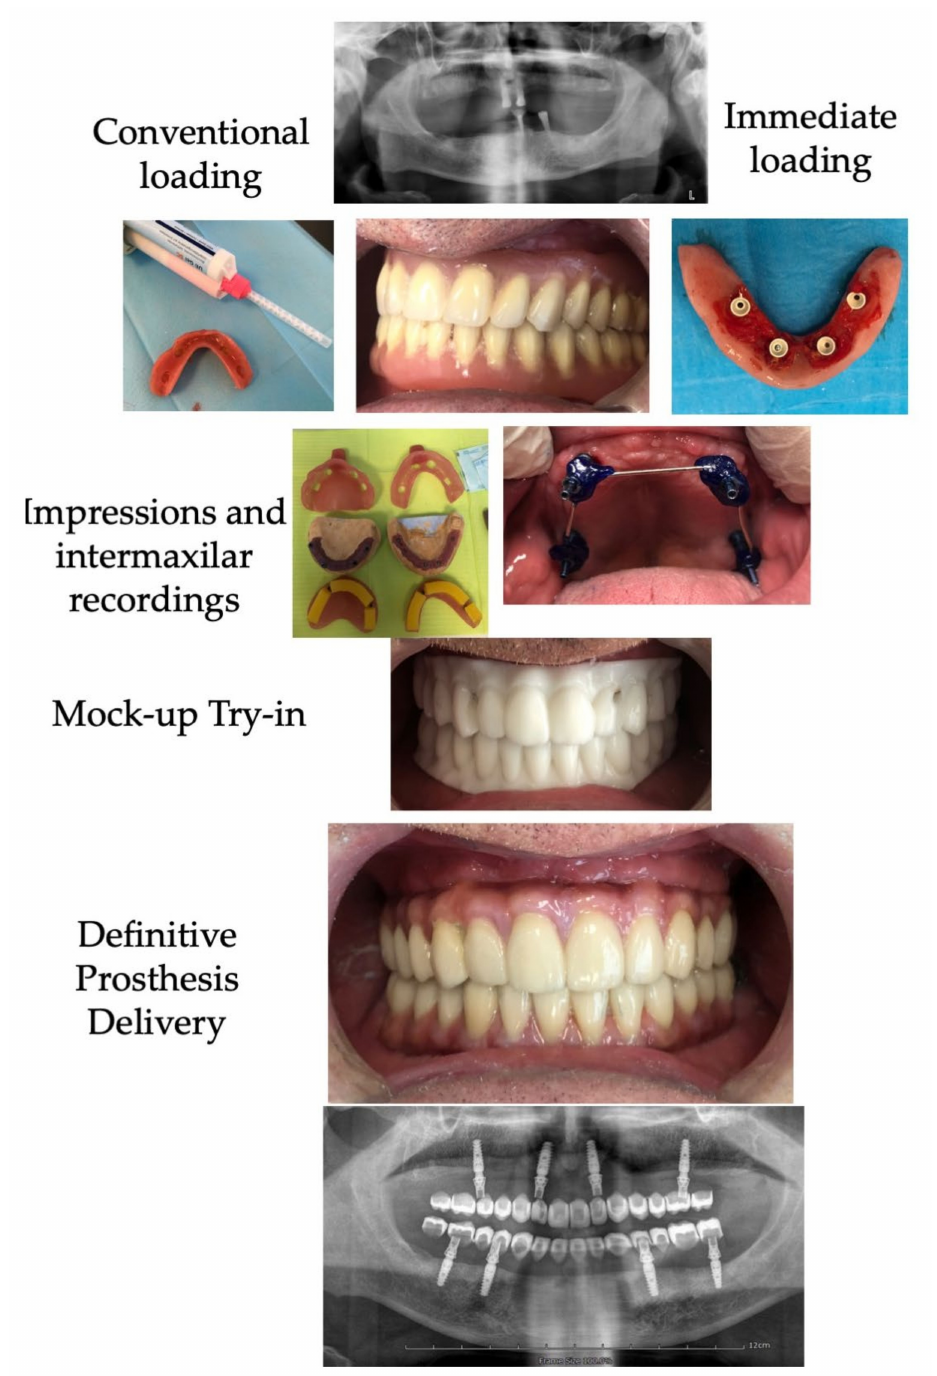
Figure 2. Diagram of the treatment steps for the rehabilitation with PEEK-NFC